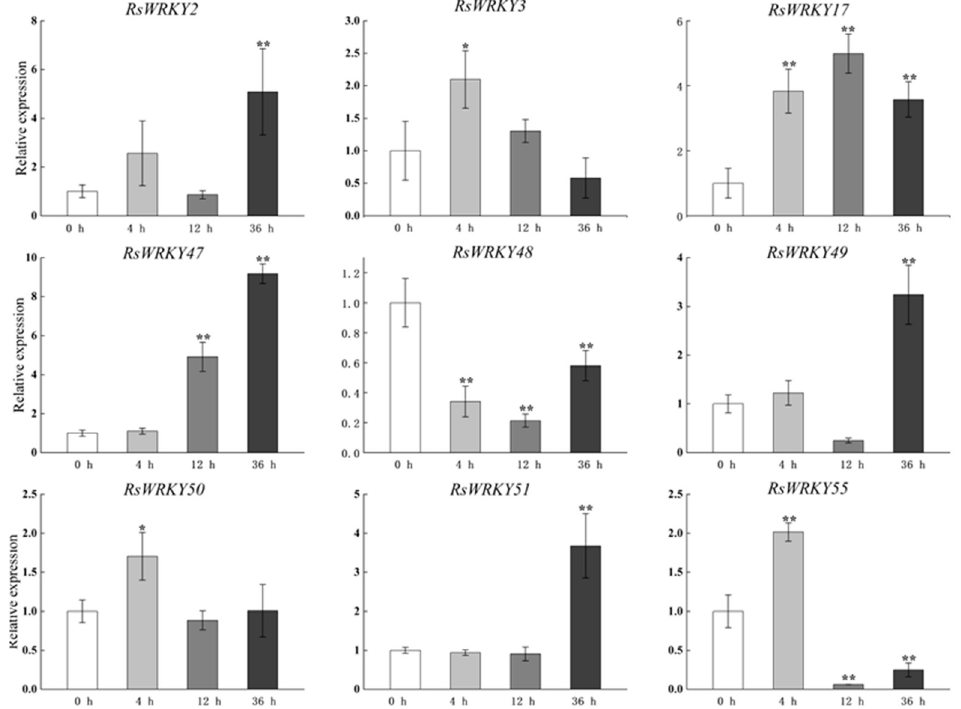
Figure 5. Expression profiles of RsWRKY genes under 100 µM GA treatment. Gene expression at 0 h was normalized as “1.” Data are mean ± standard deviation (SD), calculated from three biological replicates, and vertical lines represent the standard deviation. * and ** mean significant difference at p < 0.05 and p < 0.01, respectively.